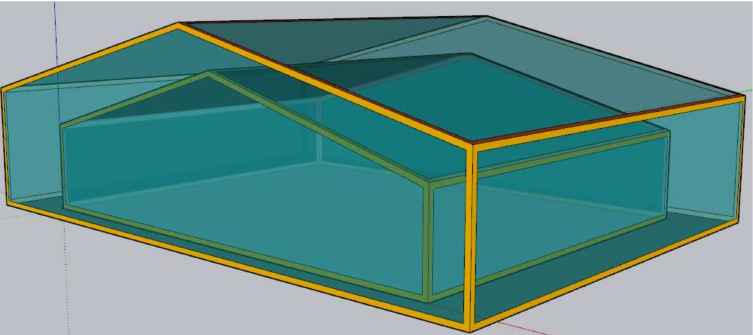
Figure 6. Three-dimensional modeling for multi-zone building in TRNSYS. Table 5. Components in TRNSYS for the internal temperature prediction model. Table 5. Components in TRNSYS for the internal temperature prediction model. Table 5. Components in TRNSYS for the internal temperature prediction model. Table 5. Components in TRNSYS for the internal temperature prediction model. Table 5. Components in TRNSYS for the internal temperature prediction model. Table 5. Components in TRNSYS for the internal temperature prediction model. Table 5. Components in TRNSYS for the internal temperature prediction model. Table 5. Components in TRNSYS for the internal temperature prediction model. Table 5. Components in TRNSYS for the internal temperature prediction model. Table 5. Components in TRNSYS for the internal temperature prediction